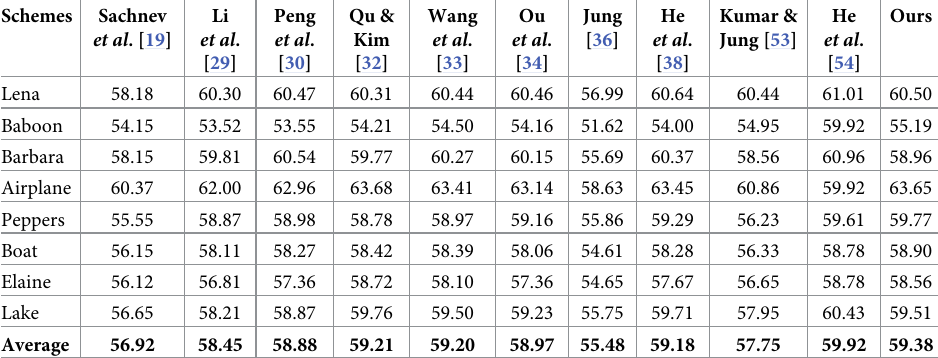
Table 3. PSNRs (dB) for embedding 10,000 bits in the USC-SIPI images. Schemes